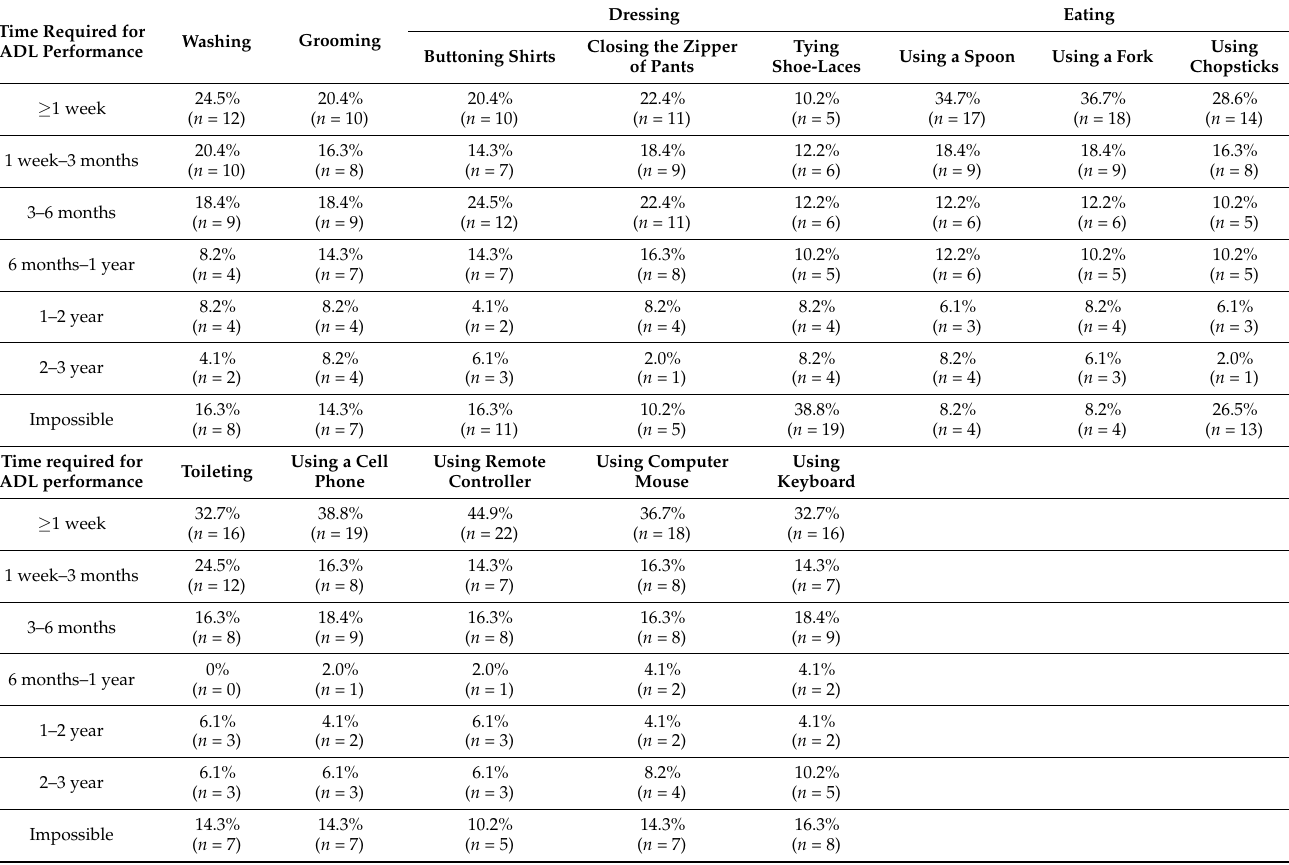
Table 9. Time required for ADL performance using prosthetic upper limb ( n =